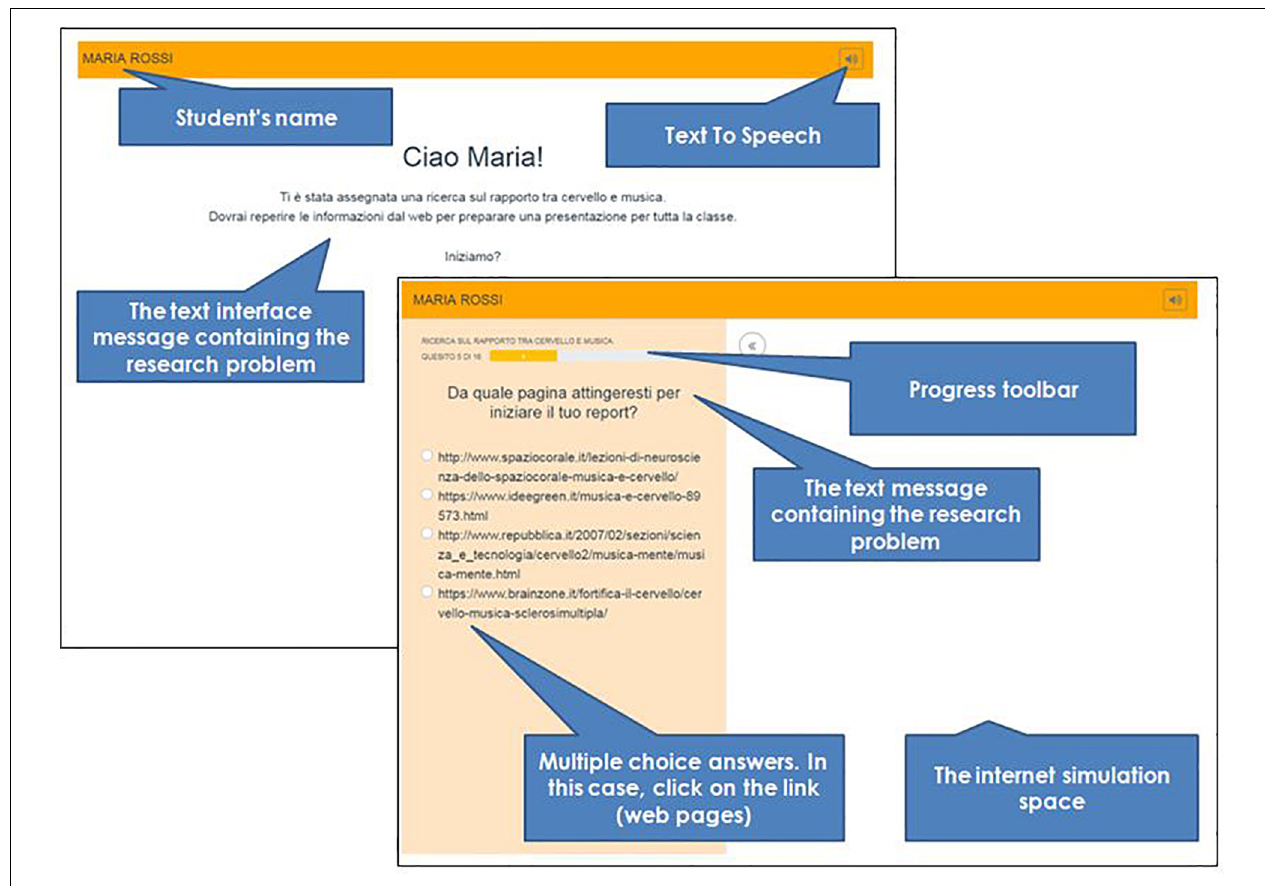
FIGURE 1 | Structure of the ORCA.IT online